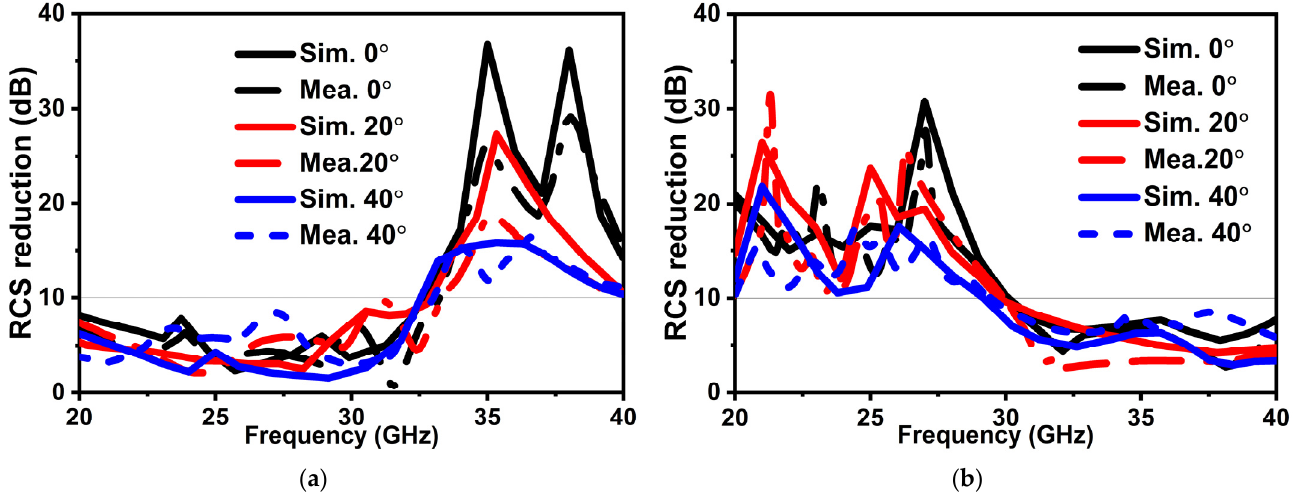
Figure 8. Simulated and measured RCS under ( a ) TE polarization and ( b ) TM polarization with θ = 0°, 20°, and 40°.